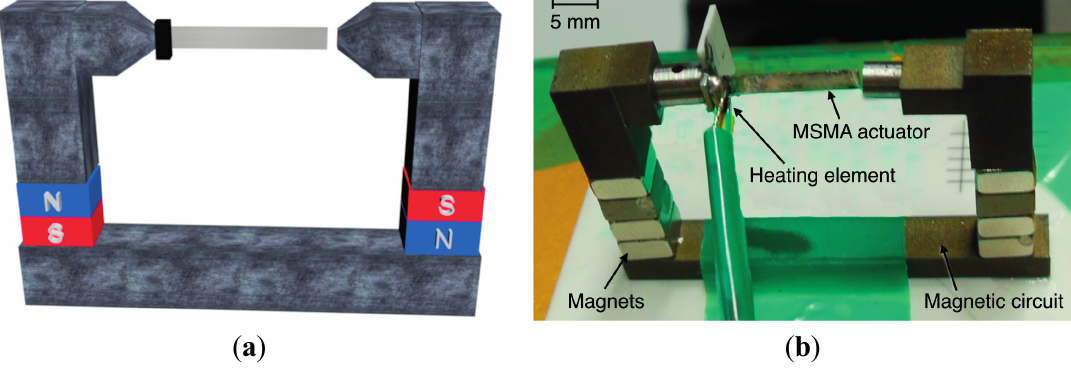
Figure 10. ( a ) Schematic of actuator setup and ( b ) photo of a linear actuator using a Ni–Mn–Ga foil of 200 µm thickness in a magnetic circuit. The size of the Ni–Mn–Ga specimen is 12 × 2 mm 2 .